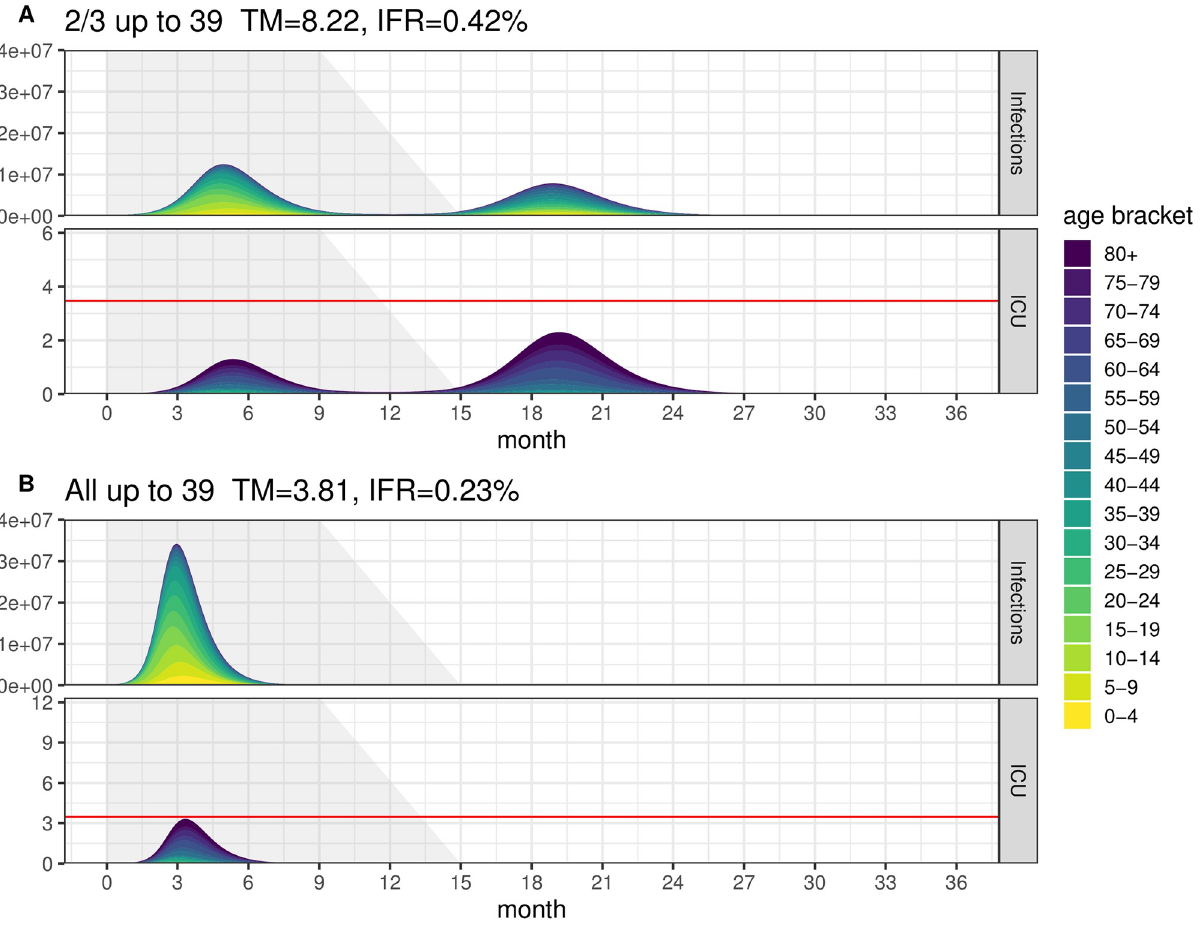
Fig 4. A : 2/3 under 39 released at normal levels. B : All under 39 released at normal levels.